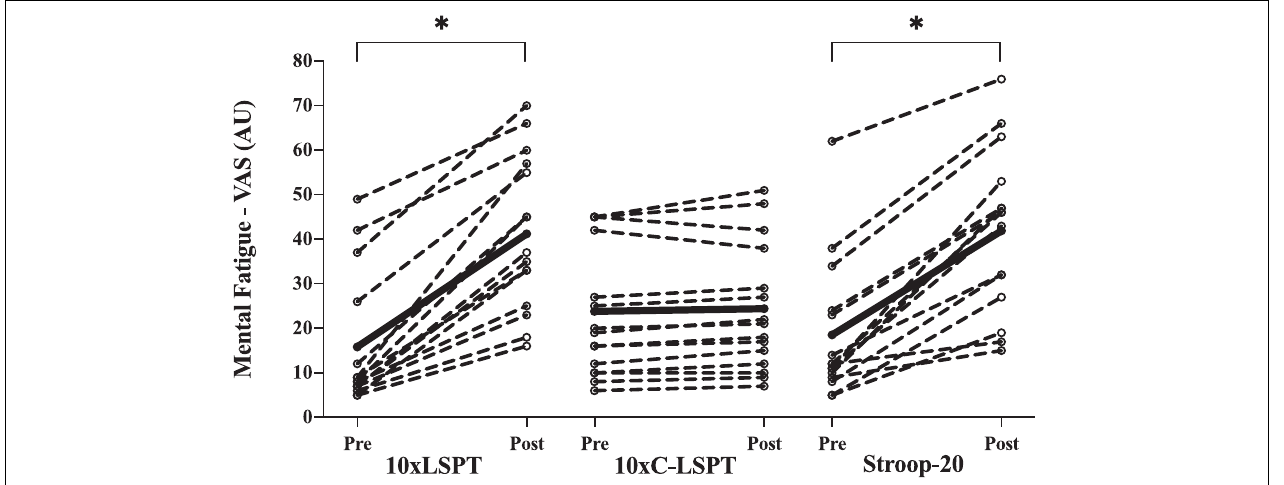
FIGURE 3 | Pre-post assessment of subjective mental fatigue. Circles and dashed lines indicate the data of individual participants, and black solid lines indicate the mean value. *Significant changes between pre- and posttest ( p < 0.05); VAS, visual analog scale; 10xLSPT, repeated interval Loughborough Soccer Passing Test; 10xC-LSPT, repeated interval modified Loughborough Soccer Passing Test in clockwise order of pass direction; Stroop-20, 20-min Stroop